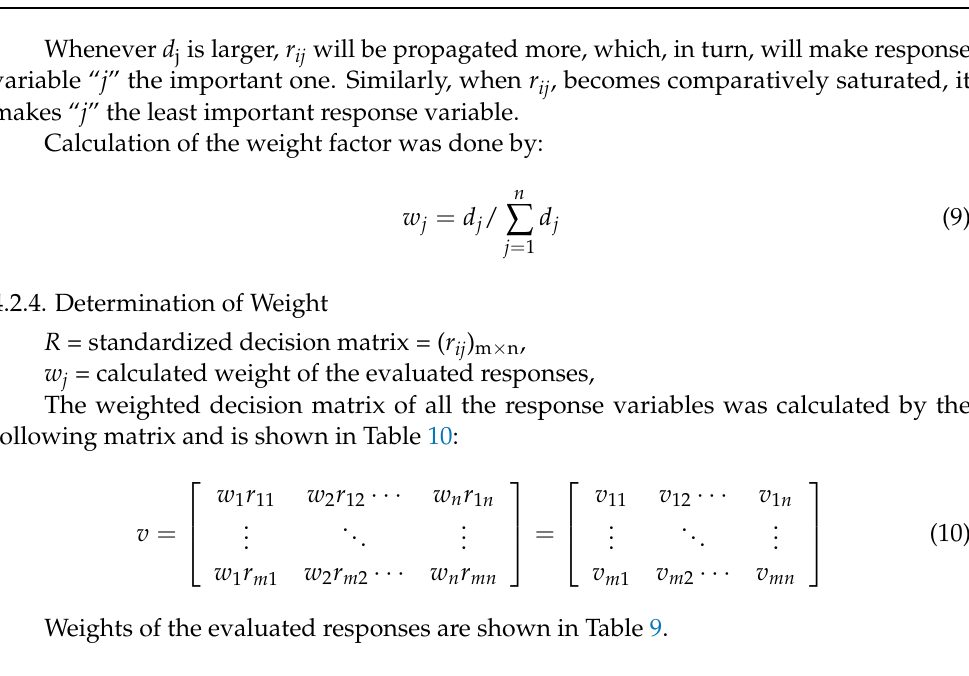
Table 9. Weights of the performance indicators.